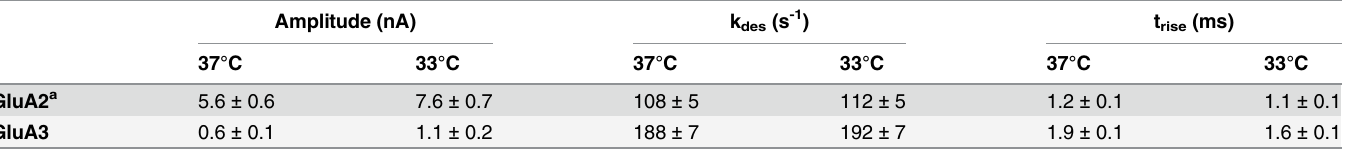
Table 1. AMPA receptor